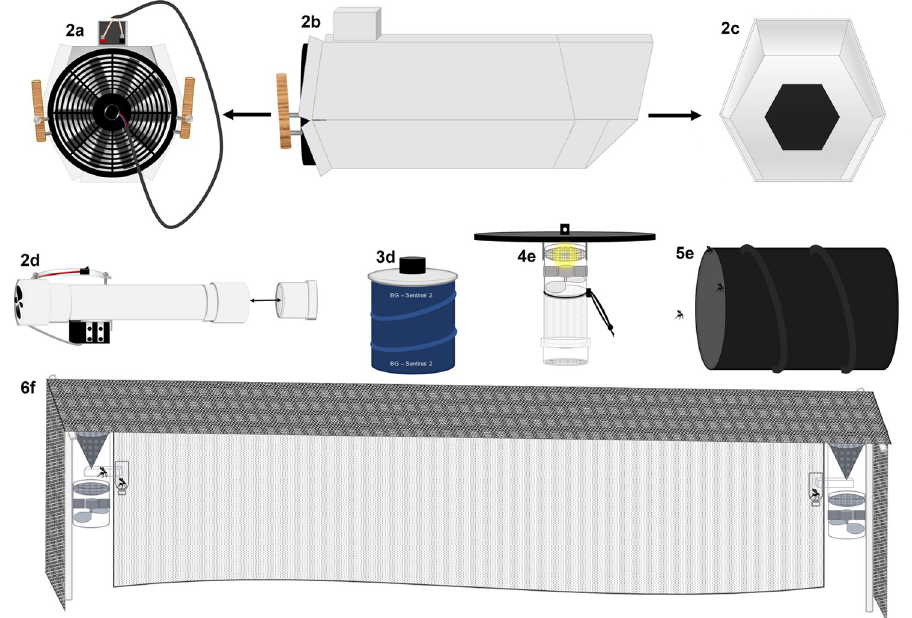
Fig 2. Illustrations of the six mosquito collection methods used by this study. Large-diameter aspirator is depicted in Fig 2A–2C. Lateral view of the small-diameter aspirator illustrated in 2d. BG-Sentinel and the CDC-light trap are illustrated in 2e and 2f respectively. The pop-up resting shelter and mosquito drift fence are illustrated in